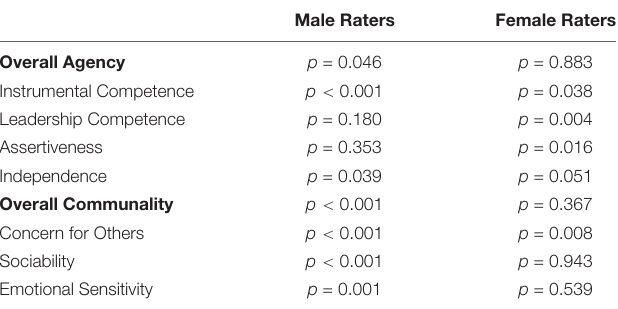
TABLE 8 | LSD comparisons of self-ratings versus target group ratings.